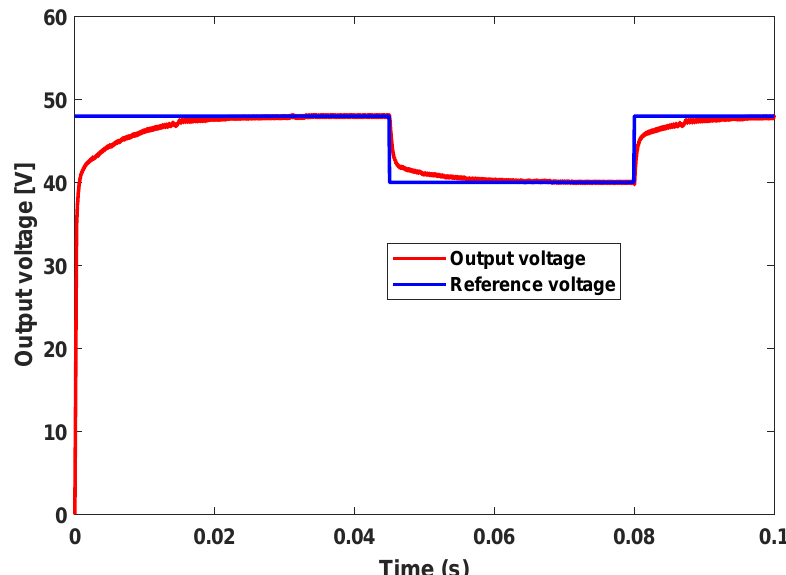
Figure 14. Dynamic response of SMC strategy in output voltage under reference voltage variations.